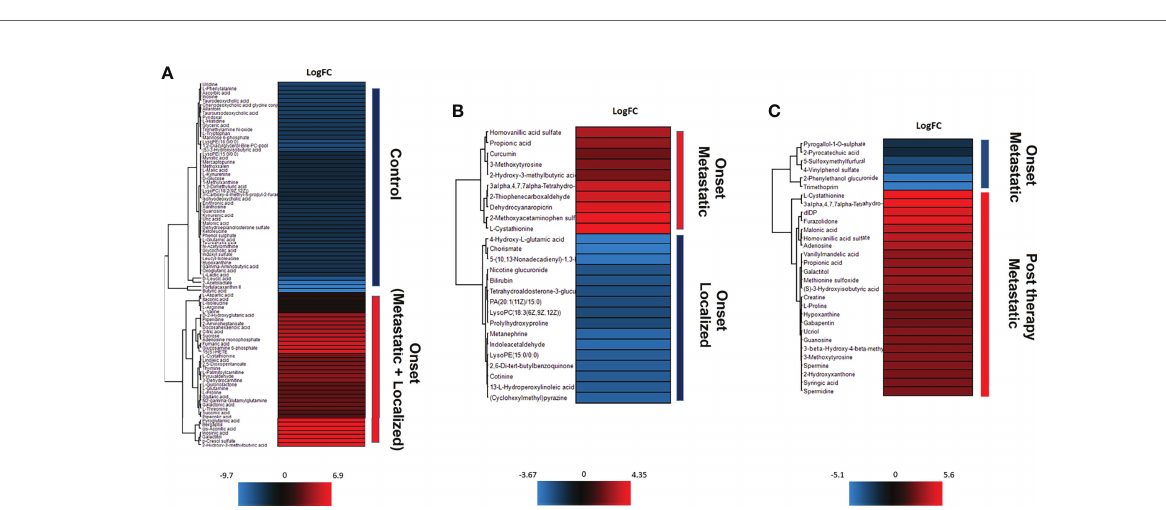
FIGURE 2 | Unsupervised hierarchical-clustered heatmap of metabolites identi fi ed by t-test in the comparison between: (A) NB patients at the onset and healthy controls. (B) metastatic and localized NB patients at the onset. (C) metastatic NB patients at the onset and after